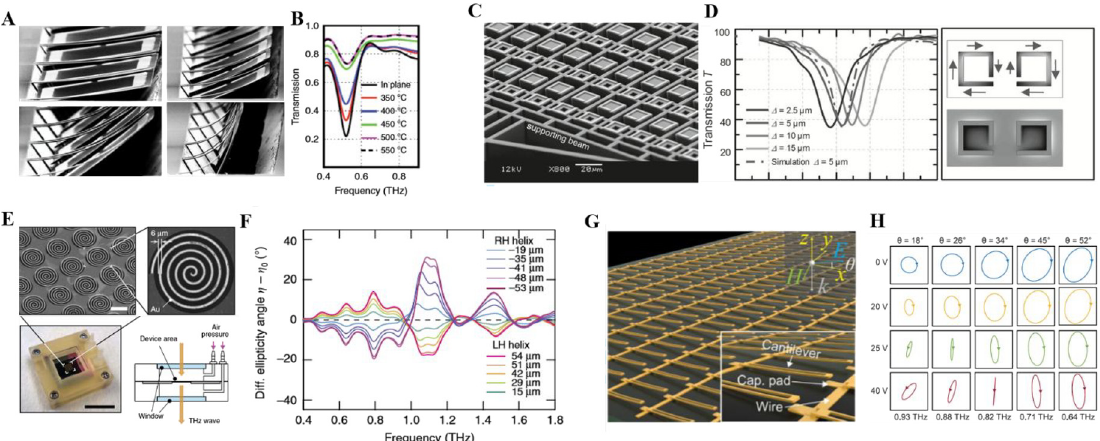
Figure 4: (A) Scanning electron microscope (SEM) image of the first thermally reconfigurable SRR metamaterial based on the pre-stressed beam and (B) its modulation in the amplitude [71]. (C) SEM image of a comb-drive actuated ASRR metamaterial and (D) its modulation in the frequency andsurface current distribution at the corresponding displacement [95]. (E) Pneumatic-actuated helix metamaterials placed inside a pressure chamber and (E) its modulation in the polarization [84]. (G) Schematic of a pre-stressed cantilever based metamaterial and (H) its application in quarter waveplates